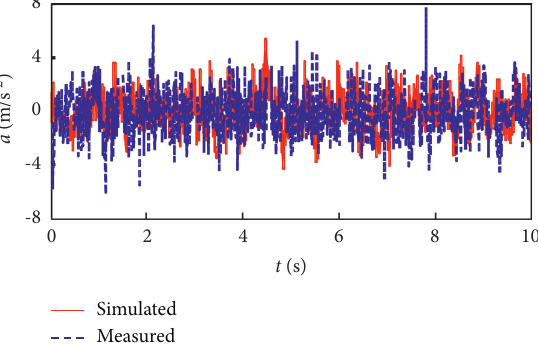
Figure 19: Vibration in the 4 th gear condition.